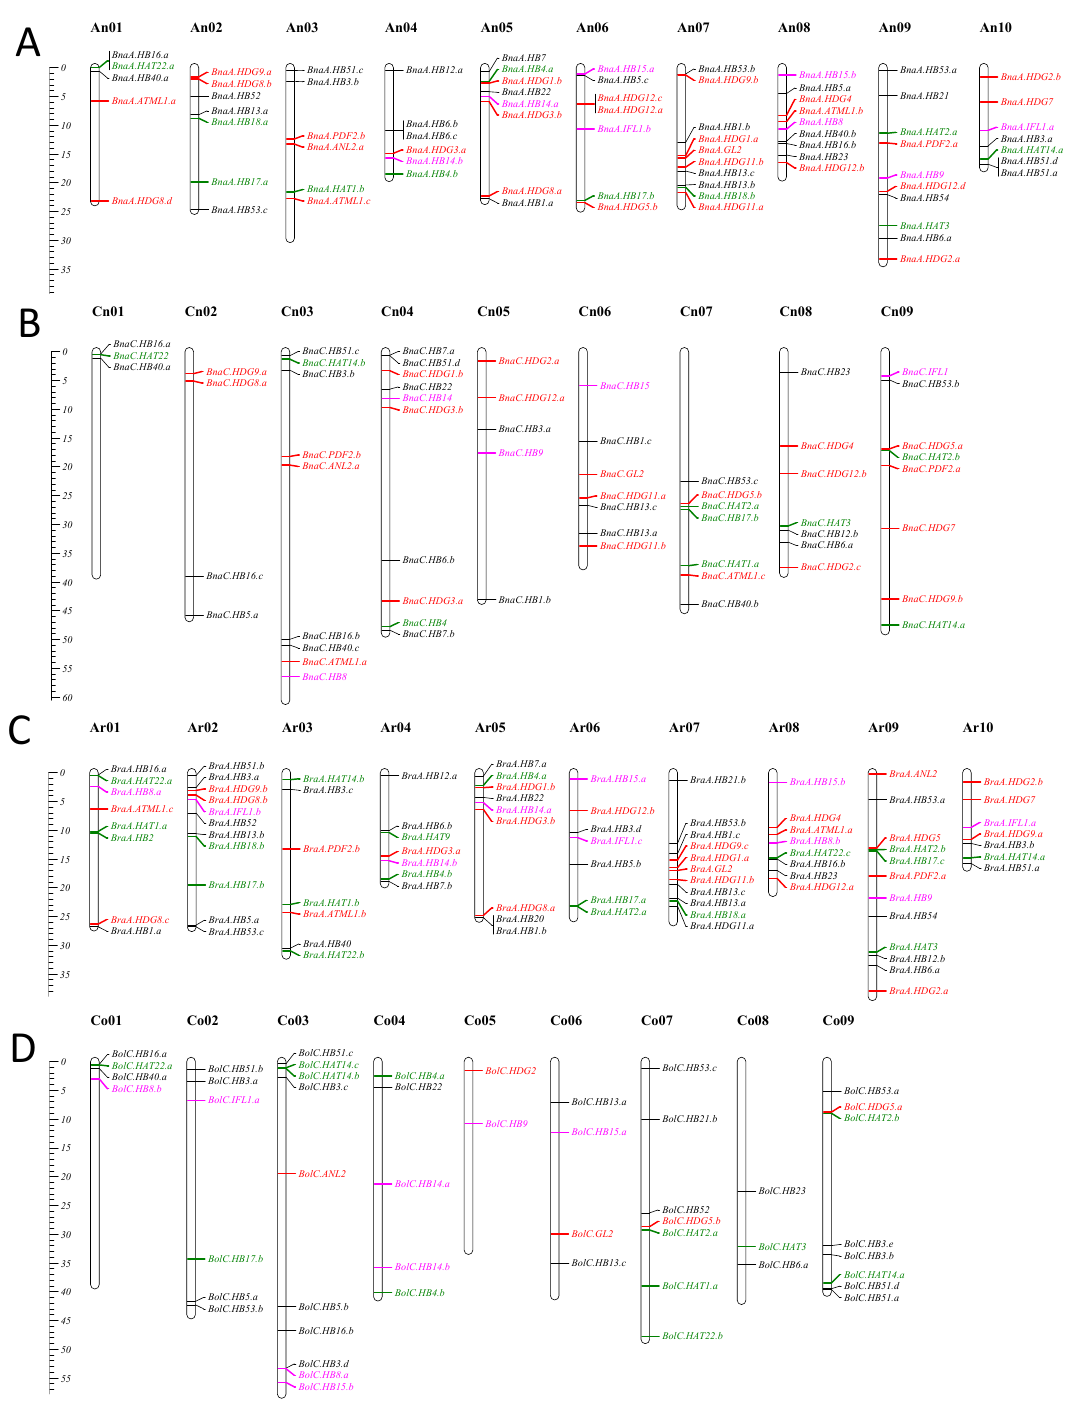
Figure 3. Chromosomal location of HD-Zip genes in B. napus ( A , B ), B. rapa ( C ), and B. oleracea ( D ). Partial HD-Zip genes are not shown in this figure due to being located in unassembled scaffolds. The scale on the left is in megabases (Mb). Genes in black, green, pink, and red represent genes belonging to subfamily I, II, III, and IV, respectively. These genes in the Ar and Co genomes were similar to those in the An and Cn